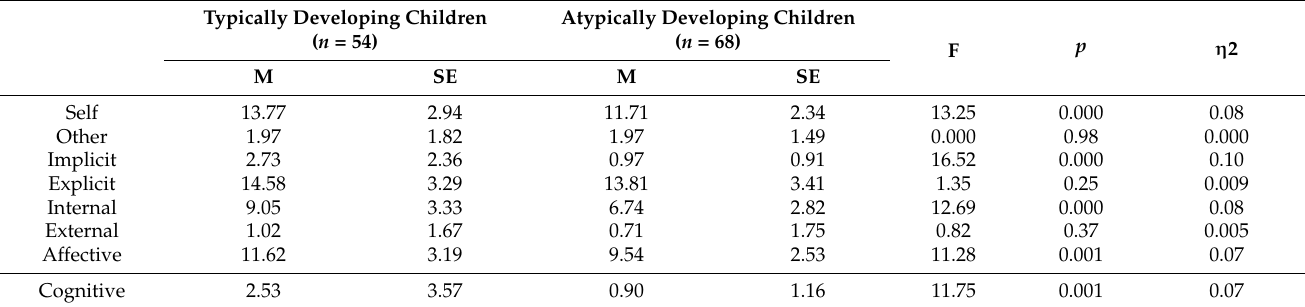
Table 5. Means, Standard Deviations, and sex Differences in CRF dimensions.